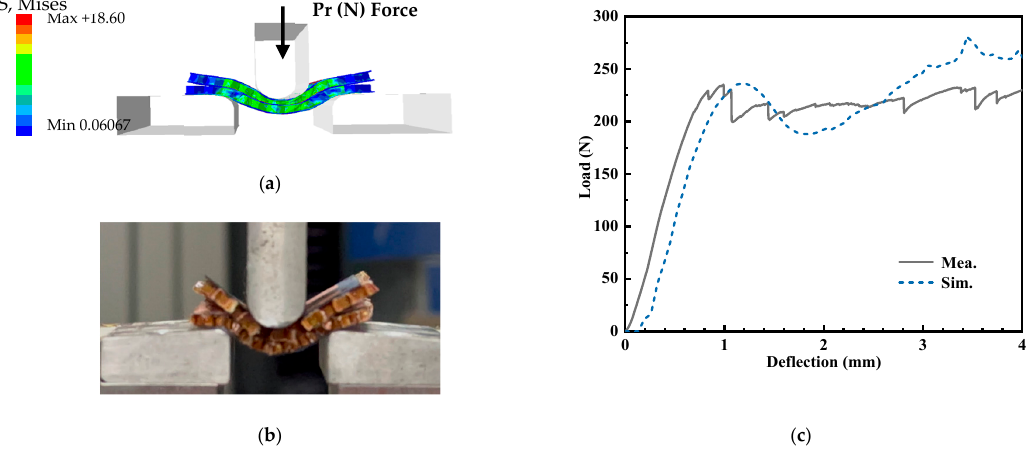
Figure 19. The three-point bending test of double-layer honeycomb sandwich panel, ( a ) simulation model ( b ) experiment environment, and ( c ) load–deflection relationships.